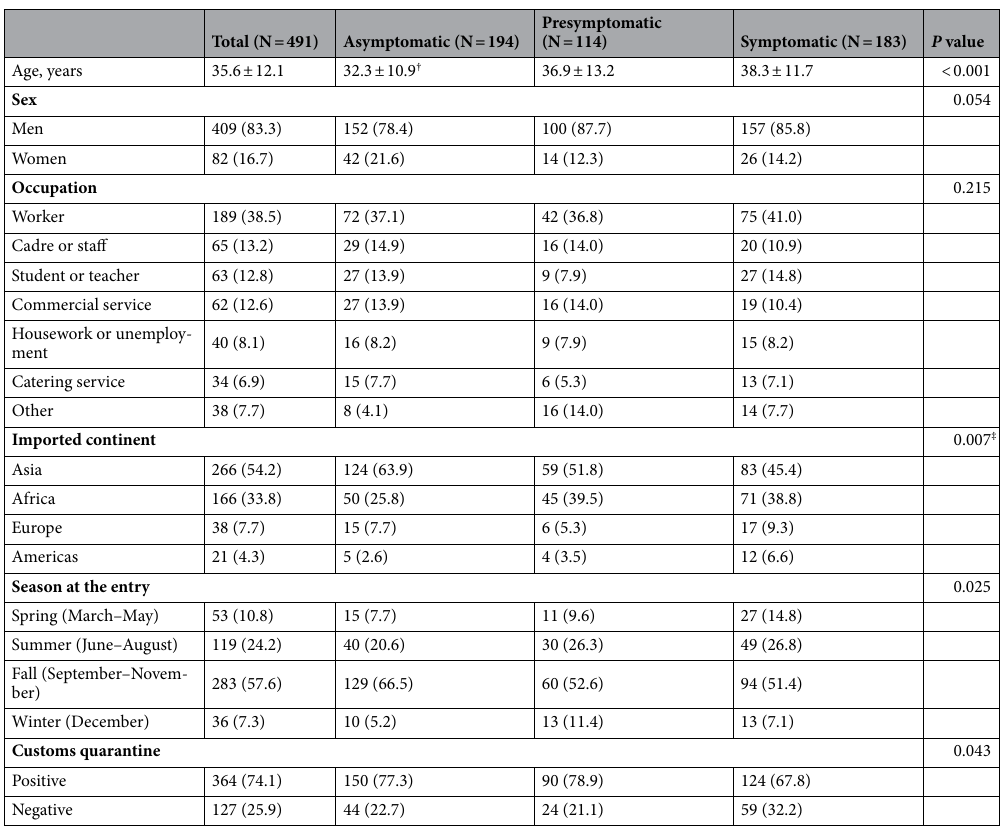
Table 1. Demographic characteristics of imported COVID-19 cases in Chengdu, China. Data are mean ± standard deviation or n (%). † Compared with presymptomatic or symptomatic cases, P < 0.01, adjusted using the Bonferroni correction. ‡ Fisher’s exact